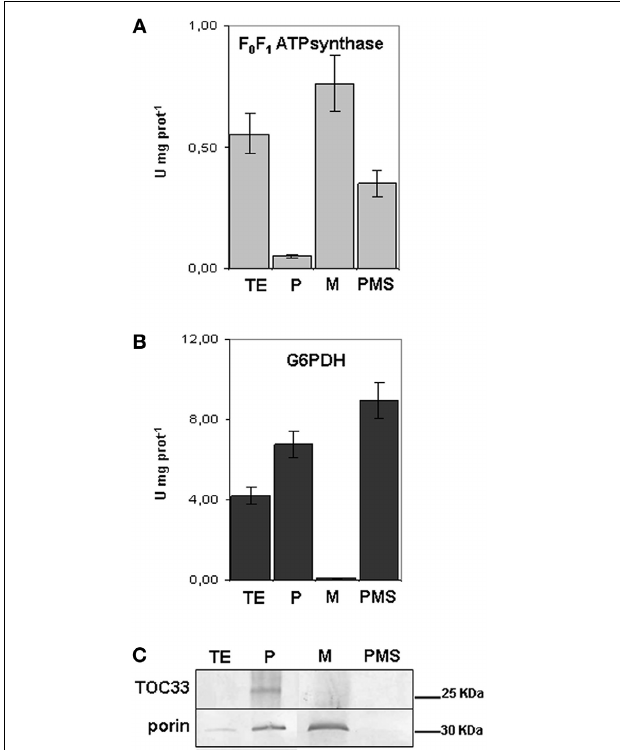
FIGURE 2 | Purity of mitochondria isolated from cucumber roots. (A) F 0 F 1 ATPsynthase activity, expressed as Units mg − 1 protein in the different fractions obtained during purification of mitochondria: total extract (TE), enriched plastids (P), mitochondria (M) and the post- mitochondria supernatant fraction (PMS). Bars represent the mean values ± SE from 4 independent samples of 30–50 µ g protein each. (B) Glucose 6-phosphate dehydrogenase activity (G6PDH) in TE, P, M and PMS fraction. Bars represent the mean values ± SE from 4 independent samples of 30–50 µ g protein each. (C) SDS-PAGE, followed by western blot analysis, of TE, P, M and PMS fractions ; equal protein quantity (12 µ g) was loaded in each lane.